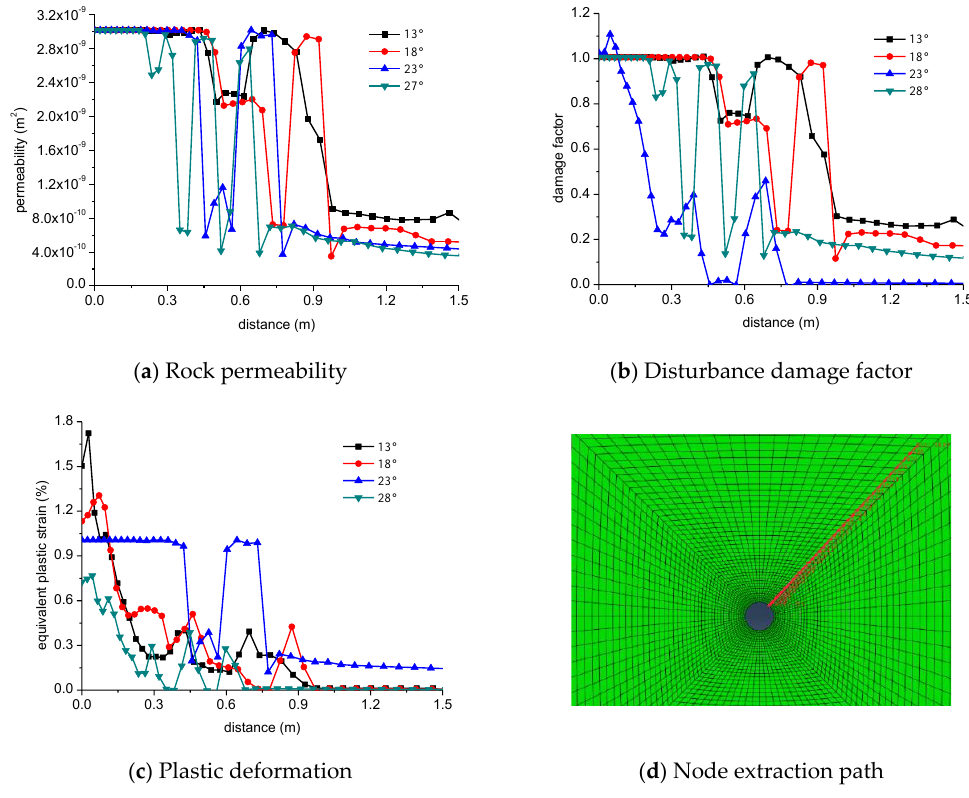
Figure 11. Variation of rock permeability, damage factor, and equivalent plastic strain with different distance.